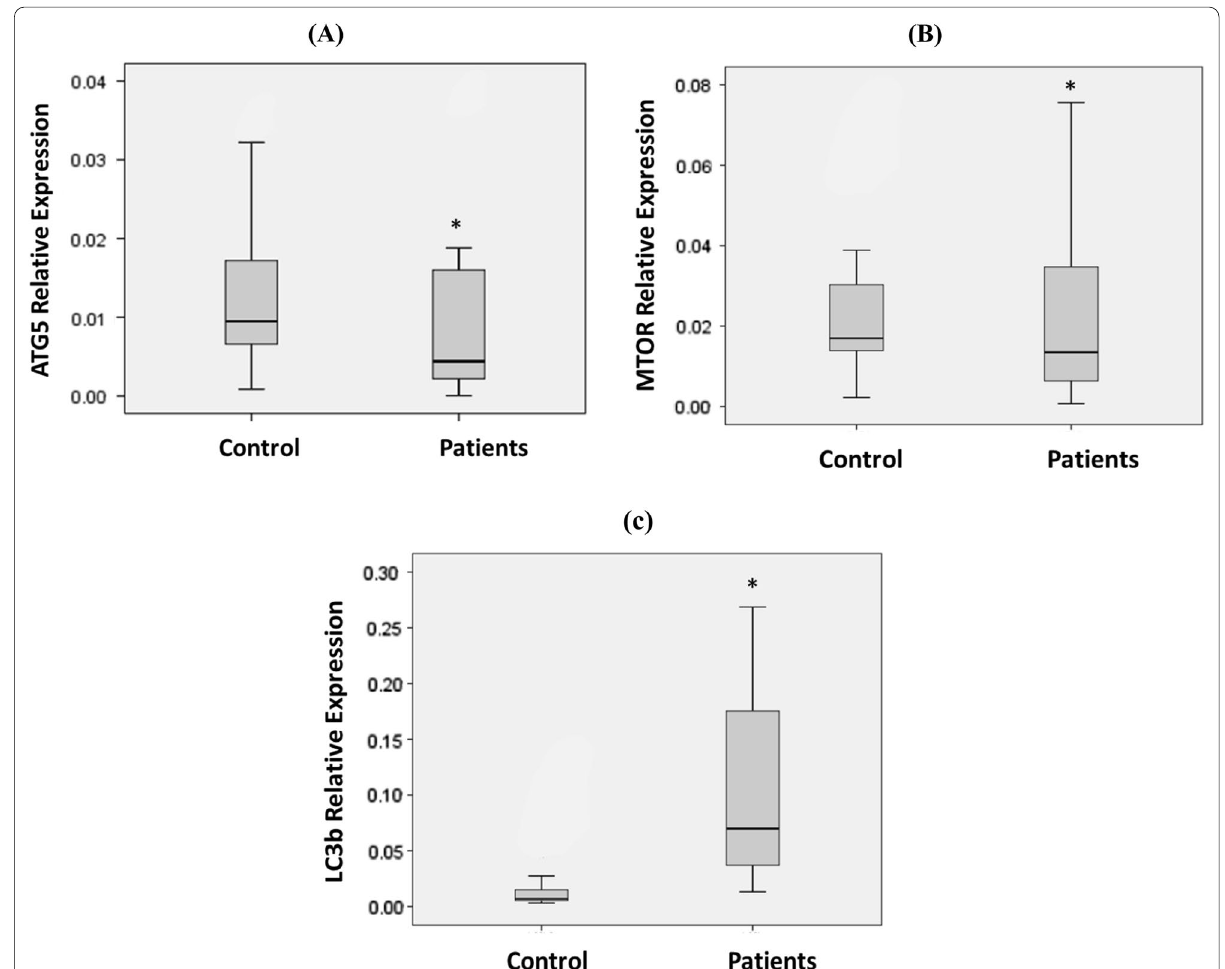
Fig. 1 Relative expression of autophagy-related genes, BD n value <